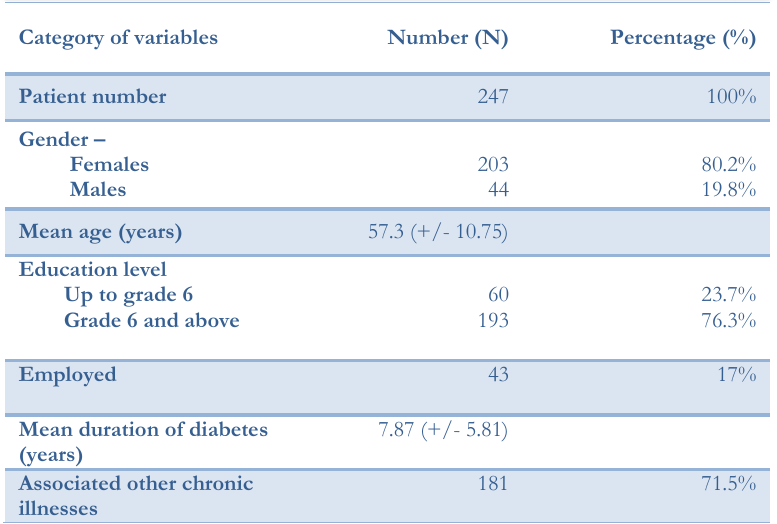
Table 1: socio-demographic